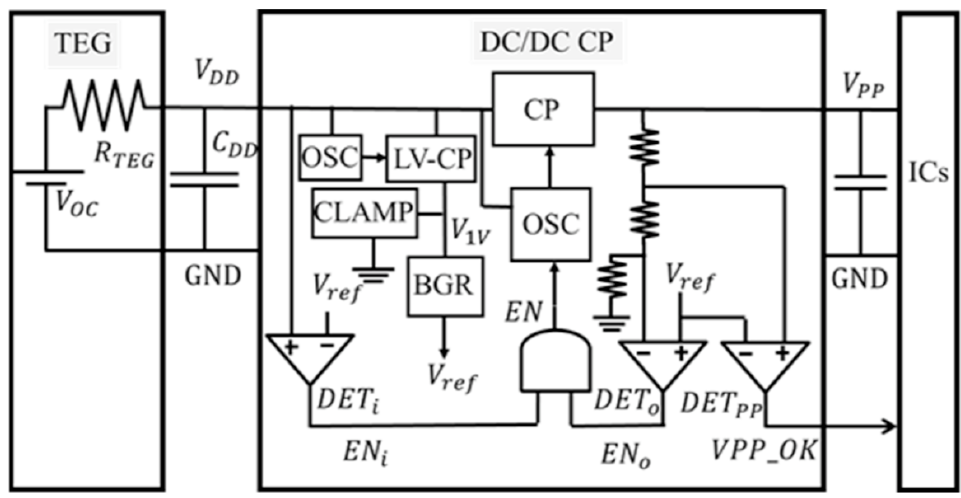
Figure 15. The double charge pump system presented in